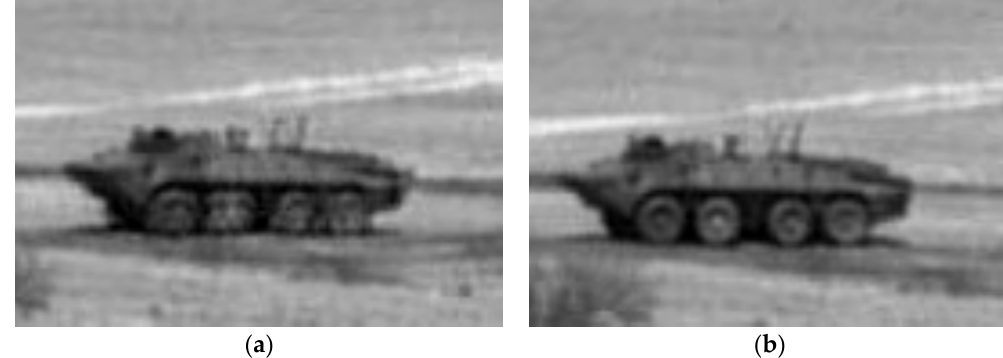
Figure 3. Comparison of no frame selection vs. frame selection for CLEAR algorithm. ( a ) No frame selection; ( b ) with frame